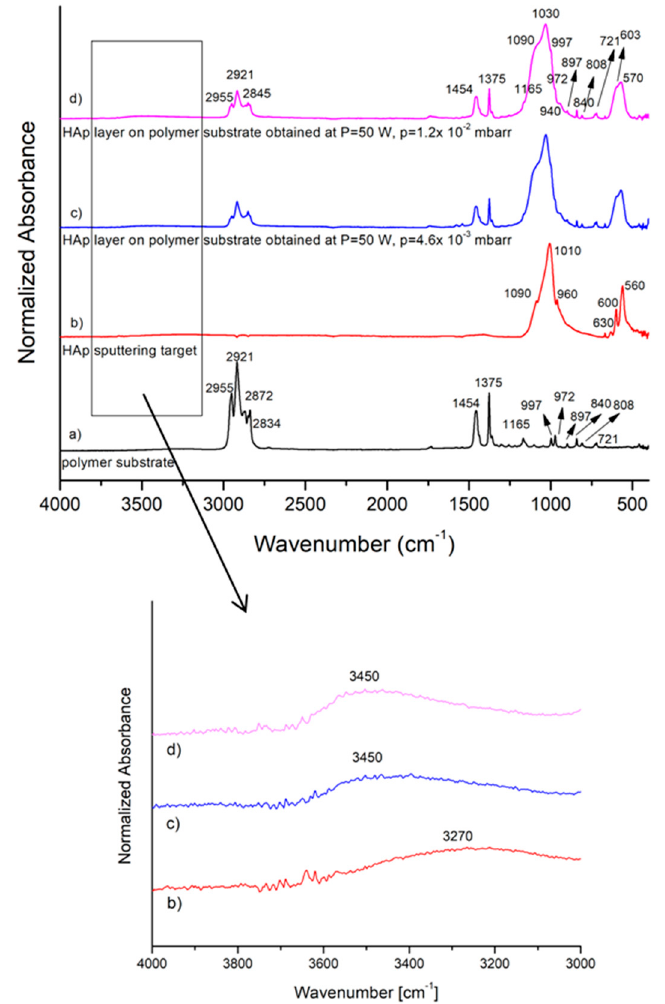
Figure 5. FTIR spectra of: ( a ) polypropylene substrate; ( b ) CaP sputtering target; ( c ) CaP coating on polymer substrate for 50 W rf power and 4.6 × 10 − 3 mbarr Ar gas working pressure; ( d ) CaP coating on polymer substrate for 50 W rf power and 1.2 × 10 − 2 mbarr Ar gas working Table 1. IR band assignment of polypropylene substrate [24], CaP sputtering target [25], and CaP coatings [12–14] on polymer substrates.